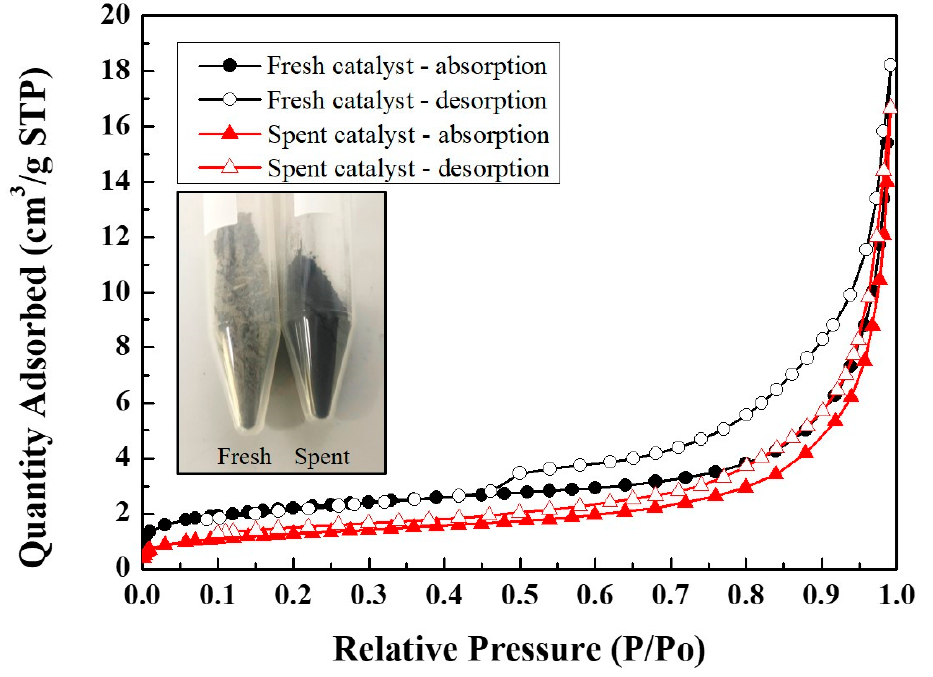
Figure 4. Adsorption-desorption isotherms of N 2 at 77K for the fresh and spent catalysts. 18